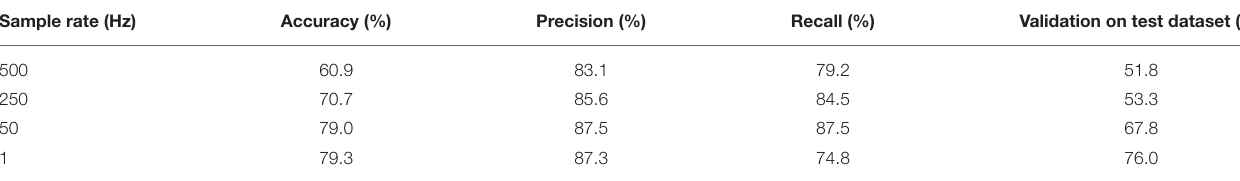
TABLE 1 | Accuracy, Precision, Recall and Validation values for all prediction models at different sample rate to determine iron